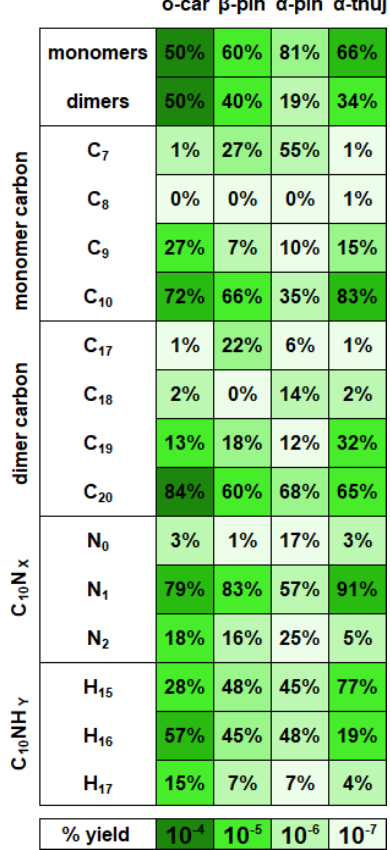
Figure 6. Ratios of reaction products separated into categories for each MT system. Each category for each MT system adds up to 100%. The color axis indicates the magnitude of the total percent yield, which can be compared across the MT systems. β -Pinene percentages are averaged from high-mixing-ratio (70ppb) and low- mixing-ratio (8ppb) experiments, but the rest of the MT systems are at the same mixing ratio